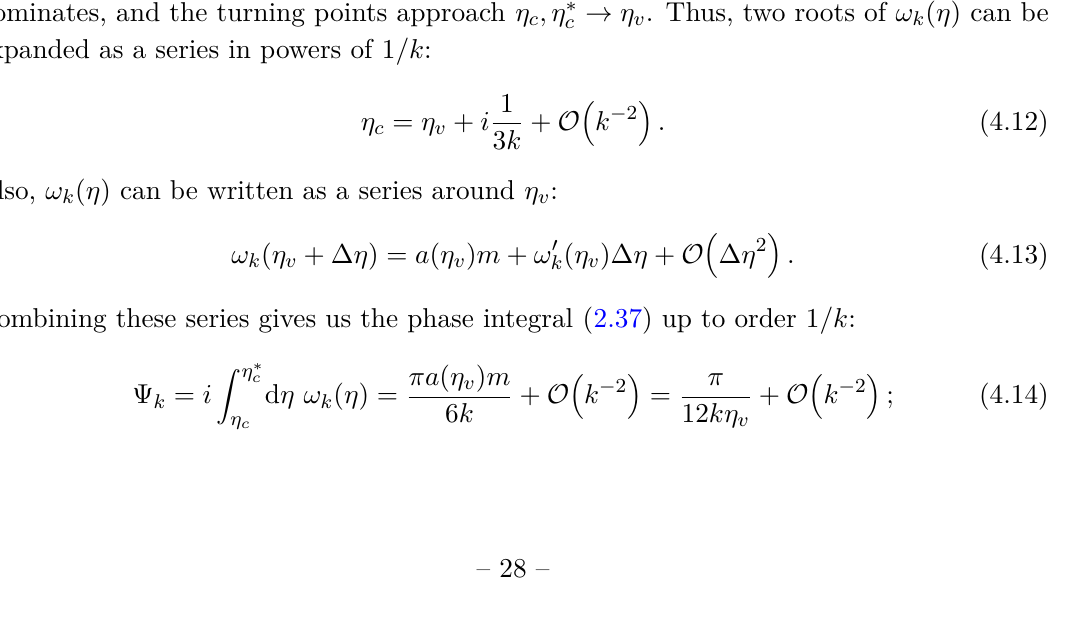
JHEP09(2022)216 (black dots) c